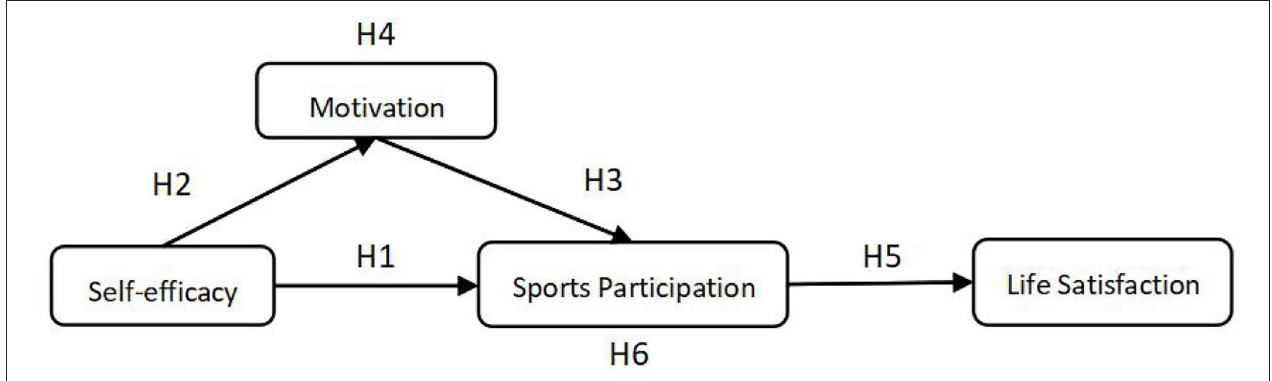
FIGURE 1 | Conceptual framework and research hypotheses of the